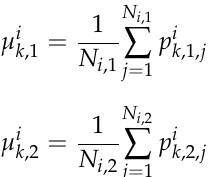
Figure 5. Given an image with a horizon line, the line segment pool is obtained through the coarse detection step. The sub-image of line segment then is extracted for fine detection, whose color feature is calculated to identify whether it is the horizon line segment.